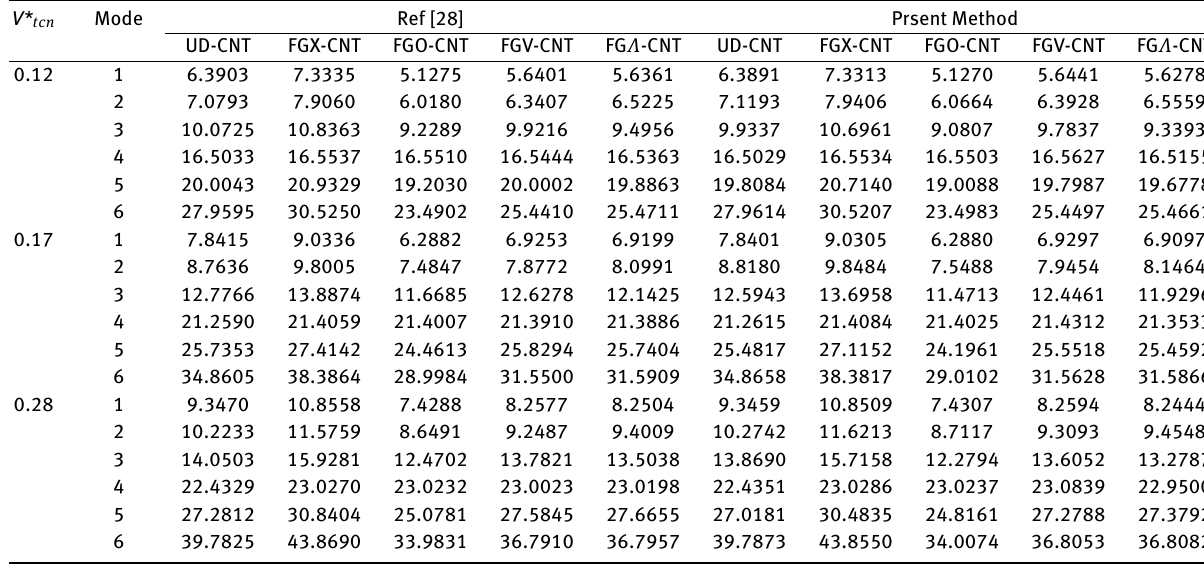
Table 5: Comparison of the frequency parameters Ω for a FG-CNT reinforced composite panel with CFFF boundary condition. V*